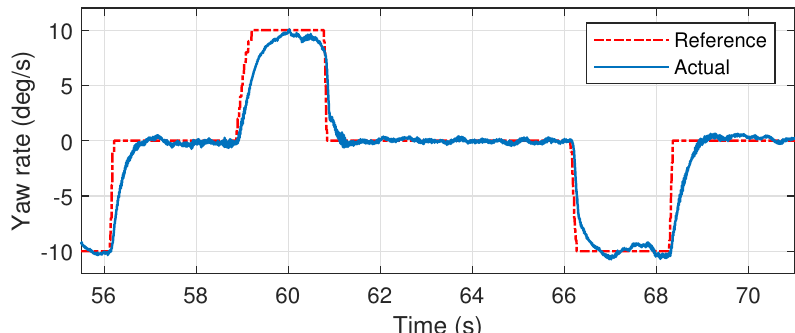
Figure 19. Yaw angular rate response.